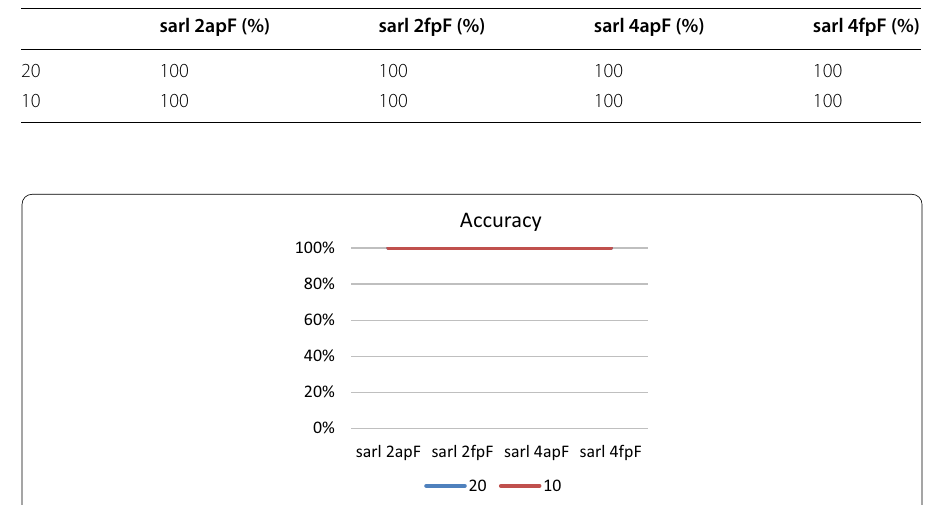
Fig. 11 Accuracy of SARL heuristic on T40I10D100K